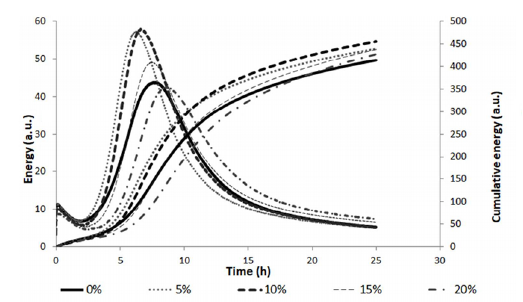
Table 1. Oxide percentages of the Class G Portland cement Figure 1. Normalized NCDTA curves and the respectives cumulative energy (arbitrary unity - a.u.) for samples with different percentages of NaCl in its hydration